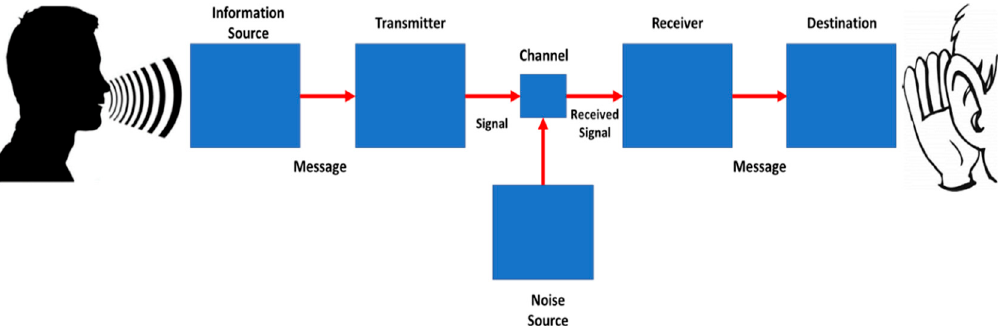
Figure 1. Schematic of a system of communication.